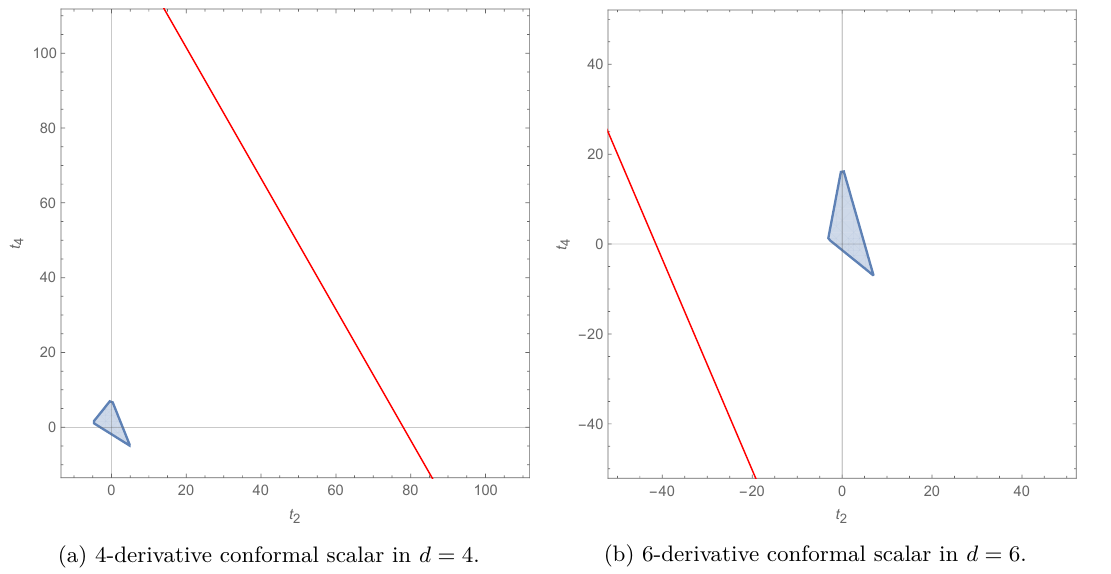
Figure 5 . The allowed region in t 2 and t 4 in d = 6 for Weyl-invariant field theories satisfying causality constraints.